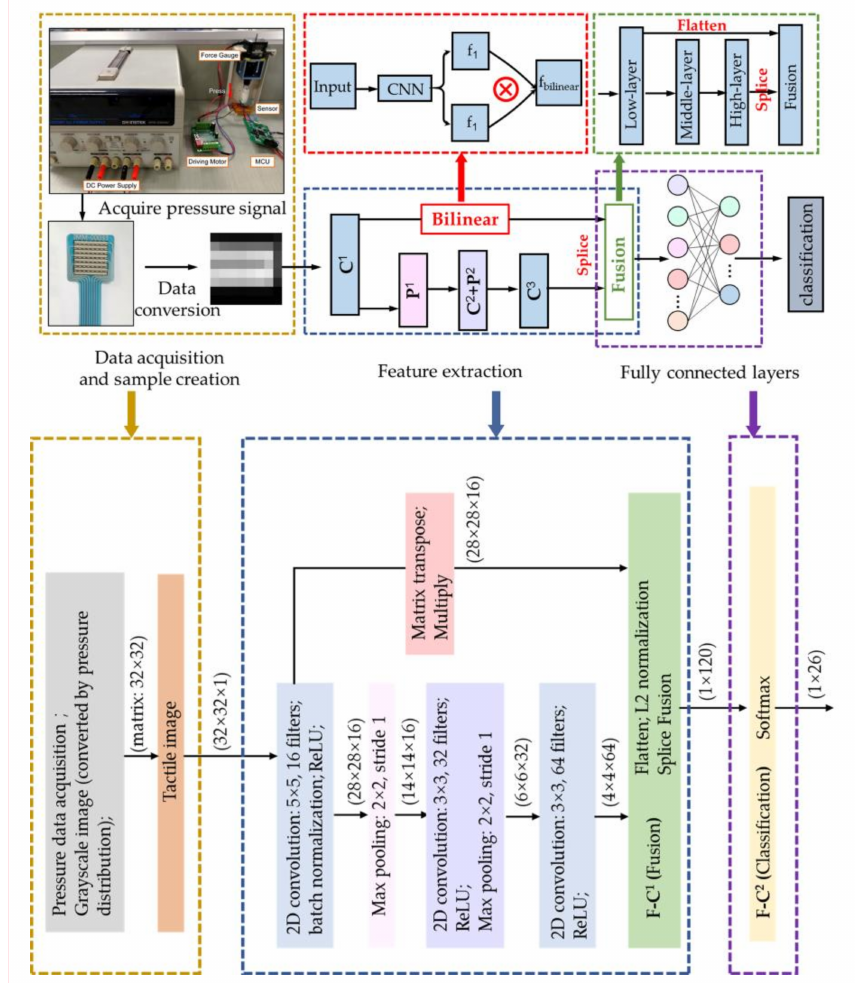
Figure 2. The framework of the proposed bilinear feature and multi-layer fused convolutional neural network